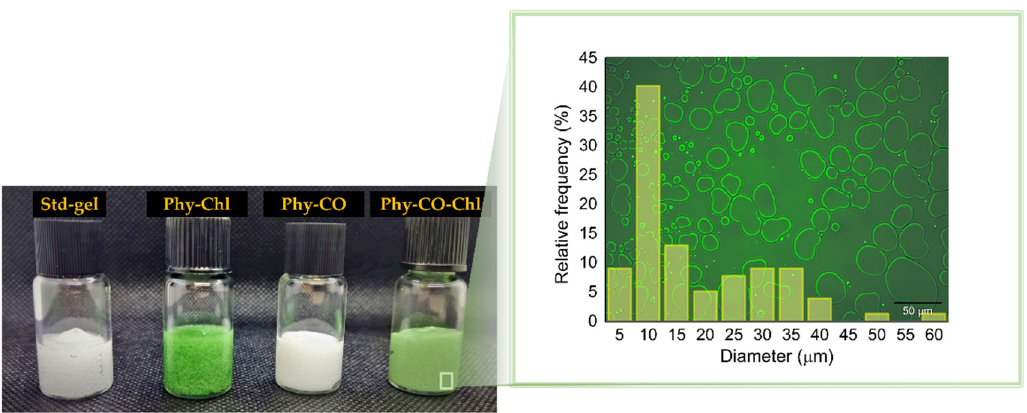
Figure 6. Photograph of the obtained k-car-based formulations. Std-gel corresponds to the polymer blend without drugs; Phy-Chl is the polymer base containing Chls, Phy-CO contains copaiba oil, and Phy-CO-Chl contains copaiba oil and Chls. The magnification represents the microstructure of the Phy-CO-Chl formulation.